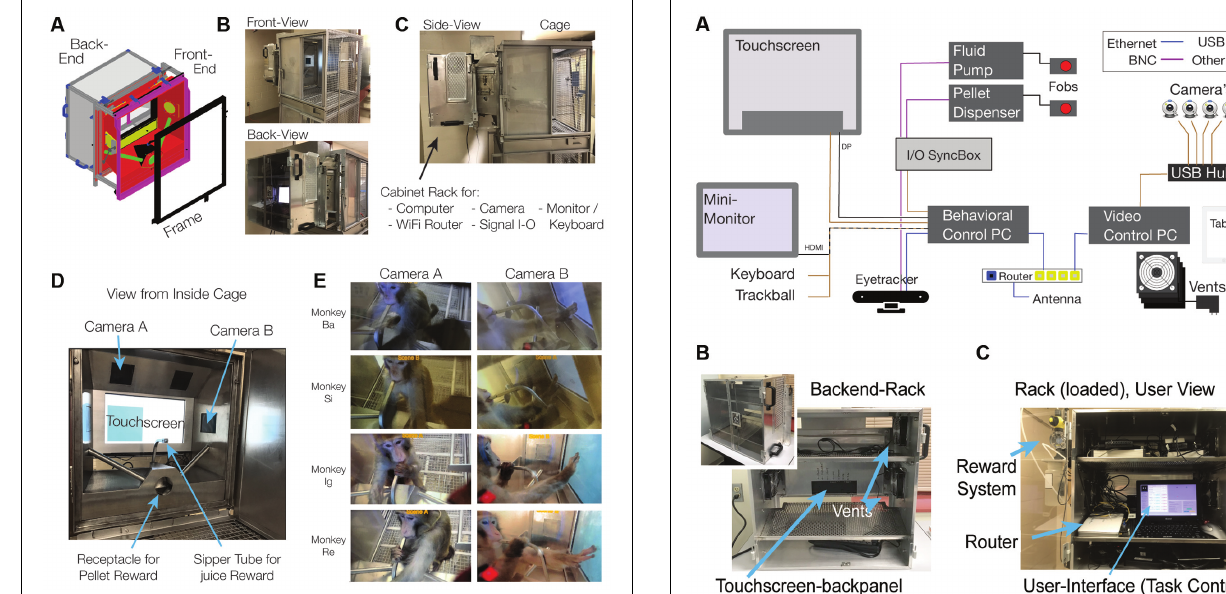
FIGURE 2 | Electronic hardware organization. (A) Diagram showing cable connections between the main electronic Kiosk components. (B) The back-end of the Kiosk is a rack with three levels. It has a transparent door, an aluminum frame for the touchscreen, USB-powered vents on both sides, and handle-bars mounted outside of the rack. (C) View inside a hardware-loaded Kiosk rack. A 11” monitor, keyboard, and trackball mouse sit on an angled shelf allowing personnel to control behavioral tasks, video-streaming, and reward